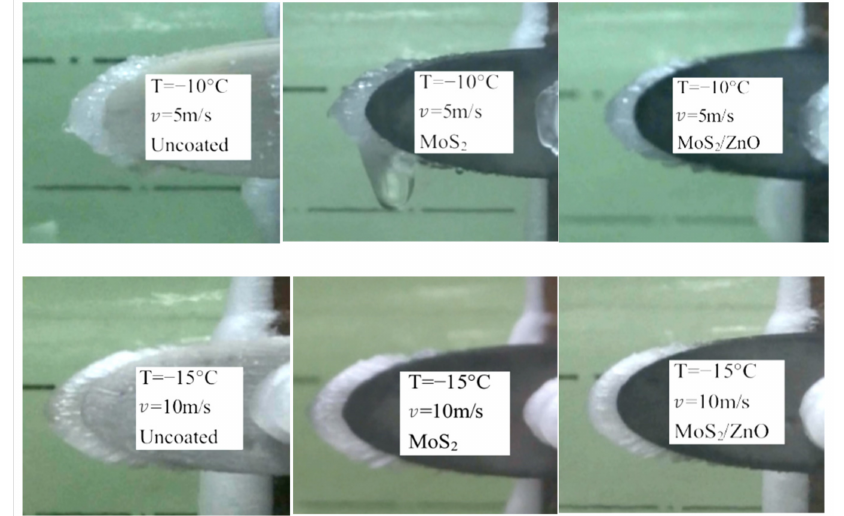
Figure 12. Icing wind tunnel test